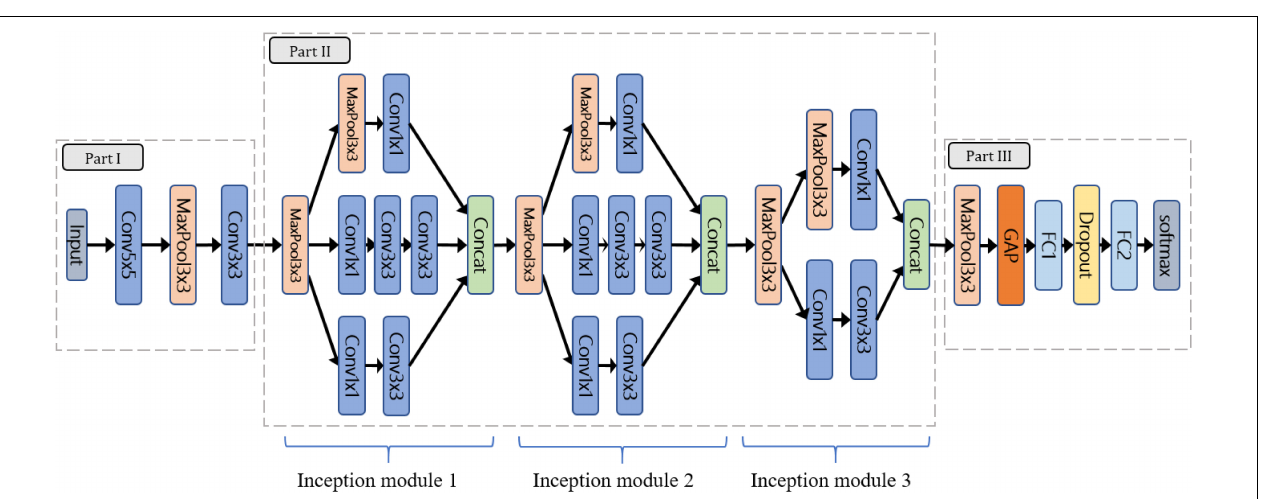
FIGURE 6 | The architecture of the proposed lightweight convolutional neural network (LtCNN). Conv is the convolution layer, Concat means concatenation operation, MaxPool denotes max-pooling layer, GAP stands for global average pooling layer, and FC means fully connected layer. A ReLu function follows every CNN process to increase the network’s